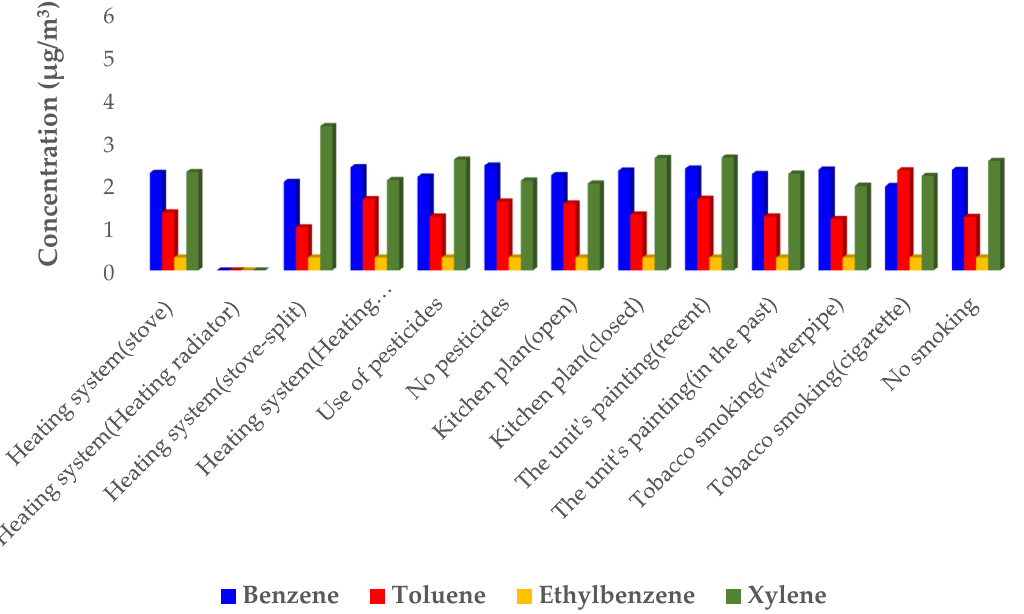
Figure 4. The relationship between the concentration of BTEX compounds ( µ g/m 3 ) and construction parameters in the control residential units.